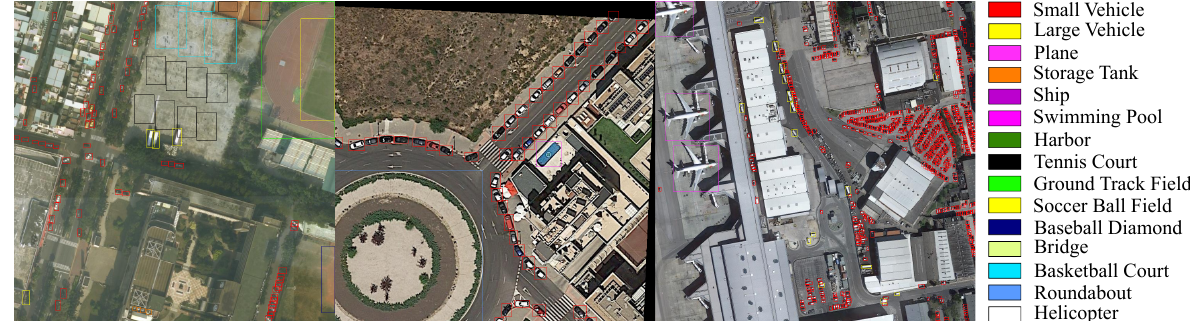
Figure 2. Three images from iSAID. The first image shows the high variety in appearance and size of the classes in iSAID. The second and third images show the high difference in terms of GSD. The color coding for the classes is applied in all figures.